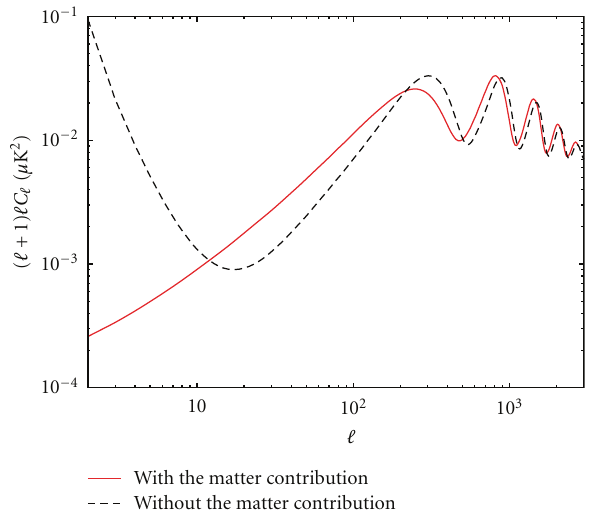
Figure 1: Comparison of CMB temperature fluctuations from the scalar mode with (red thick curve) and without (thin dashed curve) terms of O ( τ 2 ) from the matter contributions to the scale factor. For this plot, we have set B λ = 1 . 0 nG and n B = − 2 .